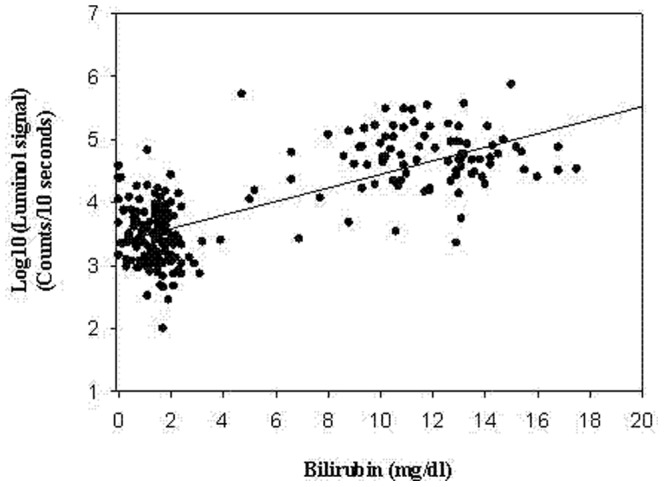
A scatter plot figure with bilirubin (on the X-axis) and the corresponding hydrogen peroxide levels with Logarithmic transformation (on the Y-axis) was presented.There is a linear relationship between these 2 values. The regression equation is H2O2 signal = 3.371+0.108*Bilirubin. The P value is <0.0001.